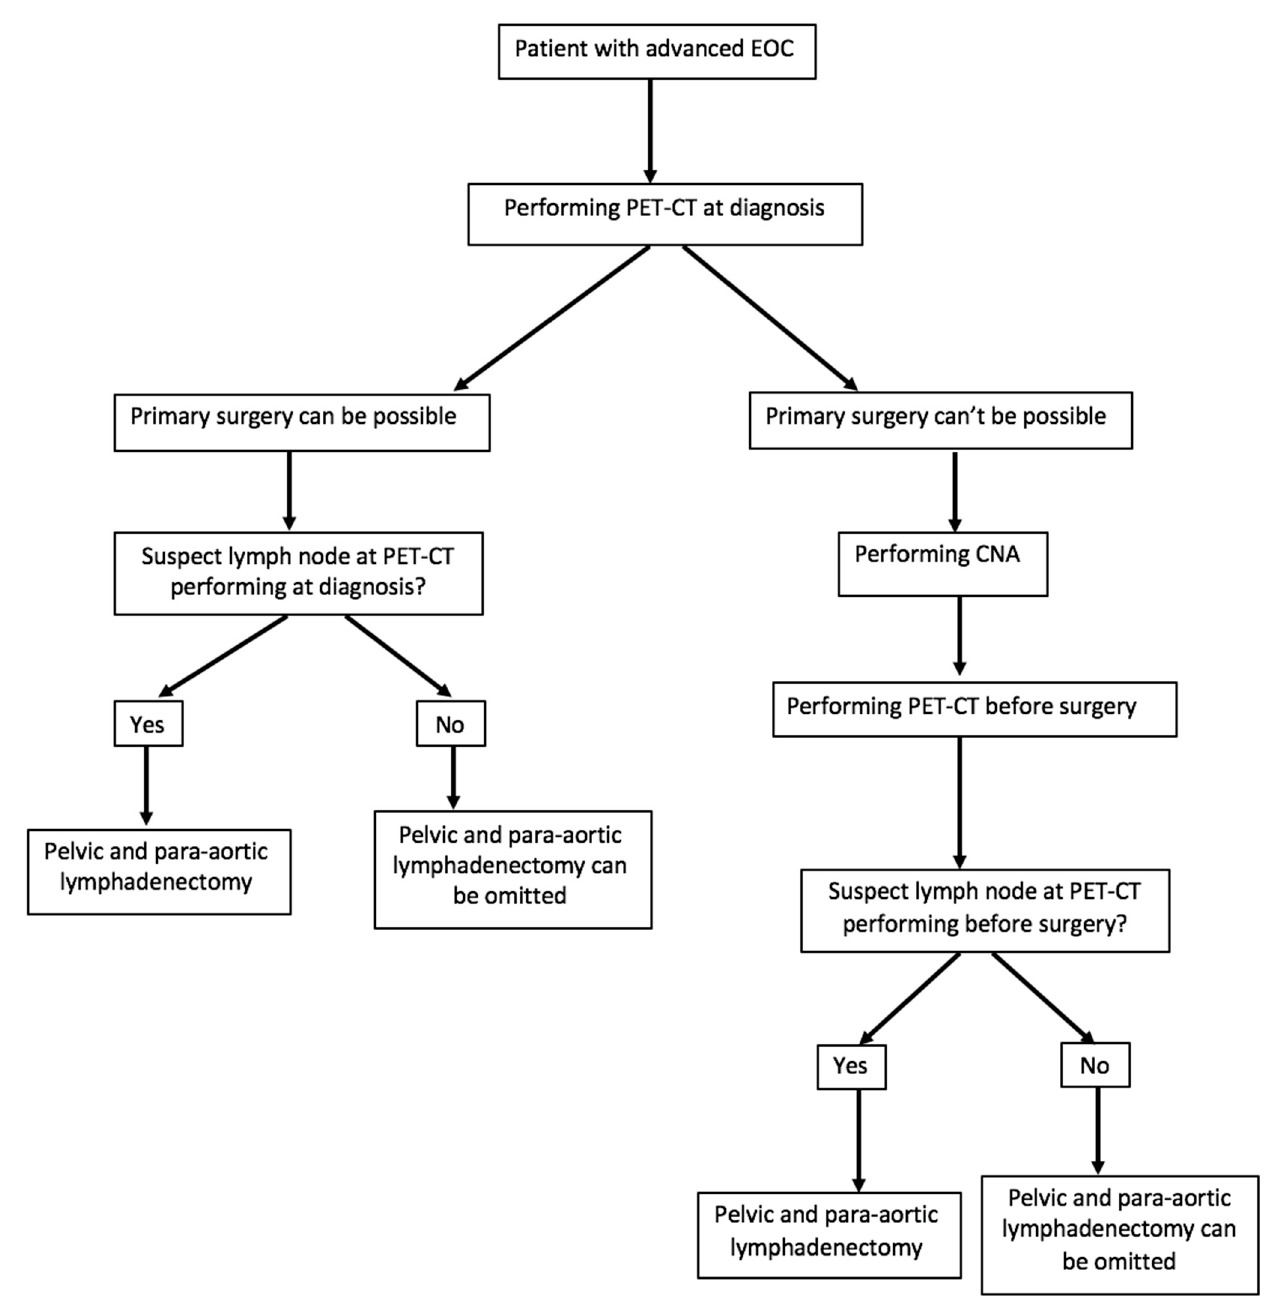
Figure 2. Proposal for the management of patients with an advanced epithelial ovarian, fallopian tubal, or peritoneal cancer (EOC) according to the results of positron emission tomography/computed tomography (PET-CT).